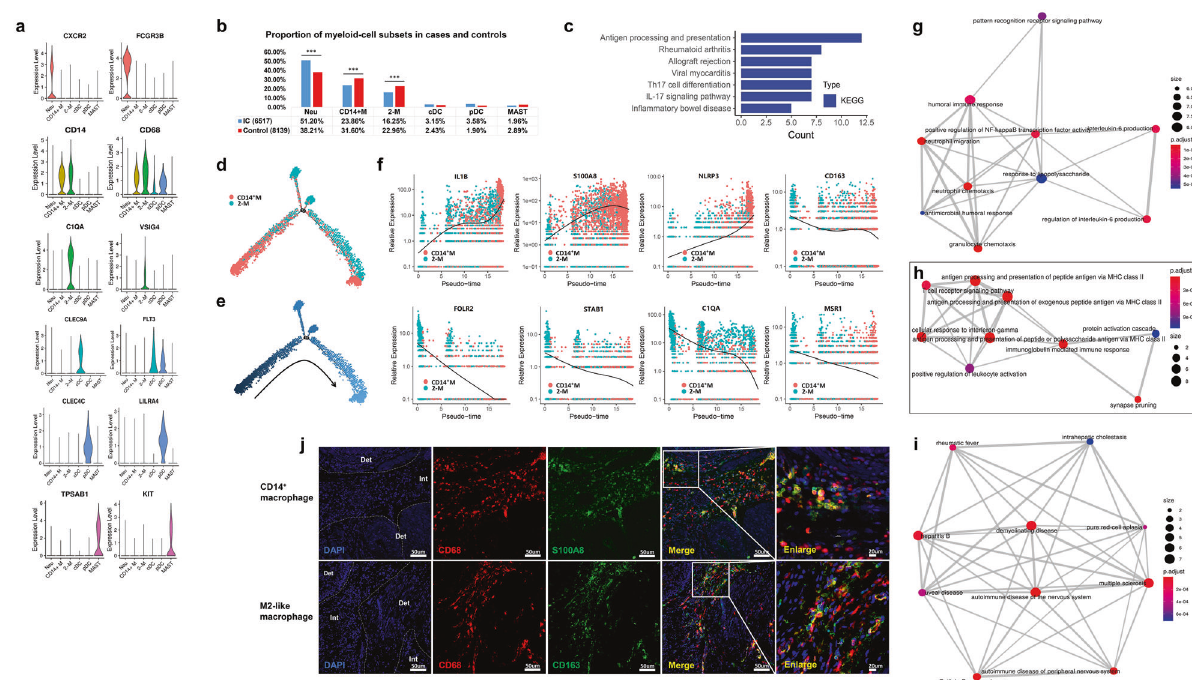
Fig. 3 Focused analysis of myeloid cells. a Violin plots showing the expression level of selected marker genes across the clusters. b The changes of proportion in myeloid-cell subsets between the two groups (*** P < 0.001). c Signi fi cant GO and KEGG terms of neutrophils in the IC group compared with the control group. d , e Pseudotime analysis depicted the developmental trajectory from CD14 + macrophages to M2- like macrophages. f Scatter plots showing the expression changes of in fl ammatory genes (IL-1 β , S100A8, and NLRP3) and phagocytosis genes (CD163, FOLR2, STAB1, C1QA, and MSR1) from CD14 + macrophages to M2-like macrophages over time. g Functional analysis of DEGs of in fl ammatory CD14 + macrophages . h Functional analysis of DEGs of M2-like macrophages . i Disease enrichment analysis of DEGs of M2-like macrophages. j Immuno fl uorescence staining of CD68, S100A8, and CD163 on frozen sections (Det detrusor, Int interstitial layer; IC, n = 15; control, n = 9). IC interstitial cystitis, DEGs differentially expressed Table S7 contained a summary of the data evaluation. After standard quality control, dimensionality reduction was performed using the Seurat methods, and visualization was realized through t -distributed Stochastic Neighbor Embedding (T-SNE). According to the DEGs in each cluster, stepwise cell clustering to construct a ST map was performed. Figure 6a presented the fi rst ST map of IC bladder. A strong correlation between the Genes and UMIs was observed (Fig. 6b). Marker genes for smooth muscle cells (SMCs) (DES, ACTG2, and CNN1), urothelial cells (KRT19), myo fi broblasts (ACTA2), interstitial cells